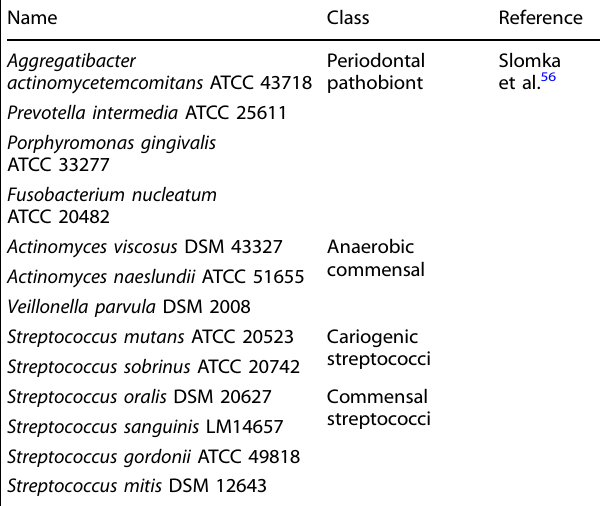
Table 4. Oral bacteria in the bio fi lm model.